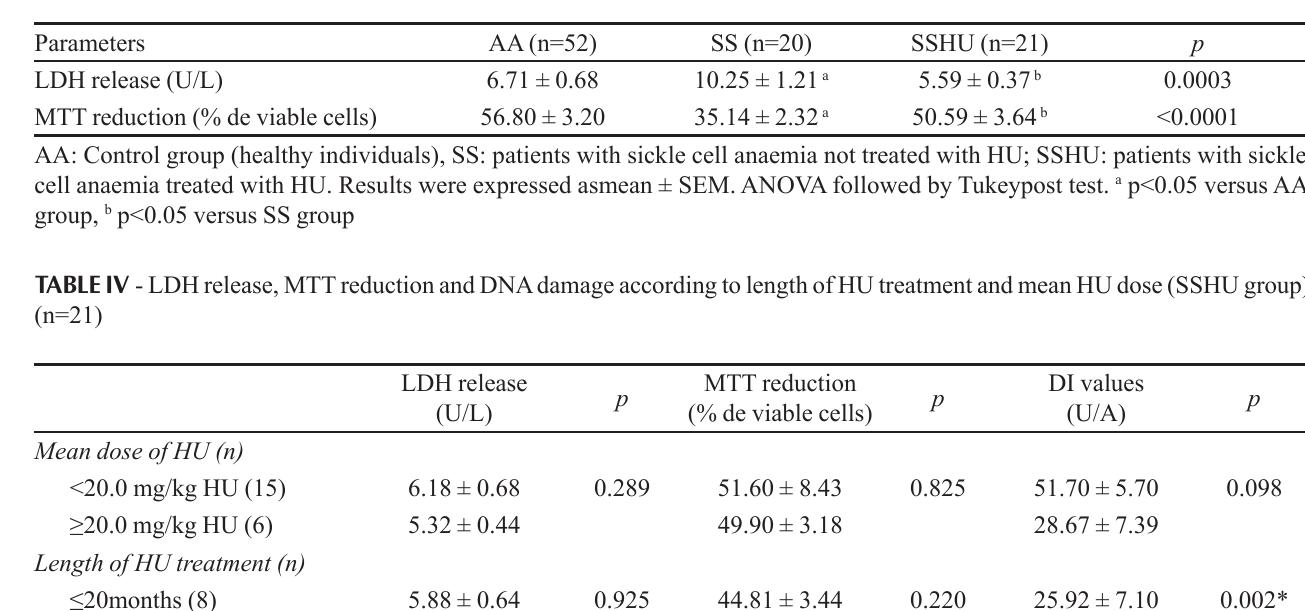
AA: Control group (healthy individuals), SS: patients with sickle cell anaemia not treated with HU; SSHU: patients with sickle